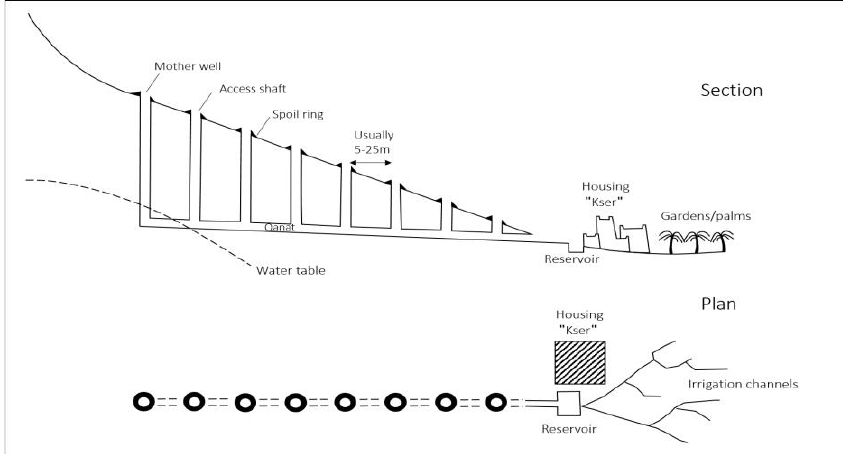
Figure 1 The sectional schema of components of ksar ecosystem (adopted by Guerrout, C. from Mobile Technologies in the Ancient Sahara and